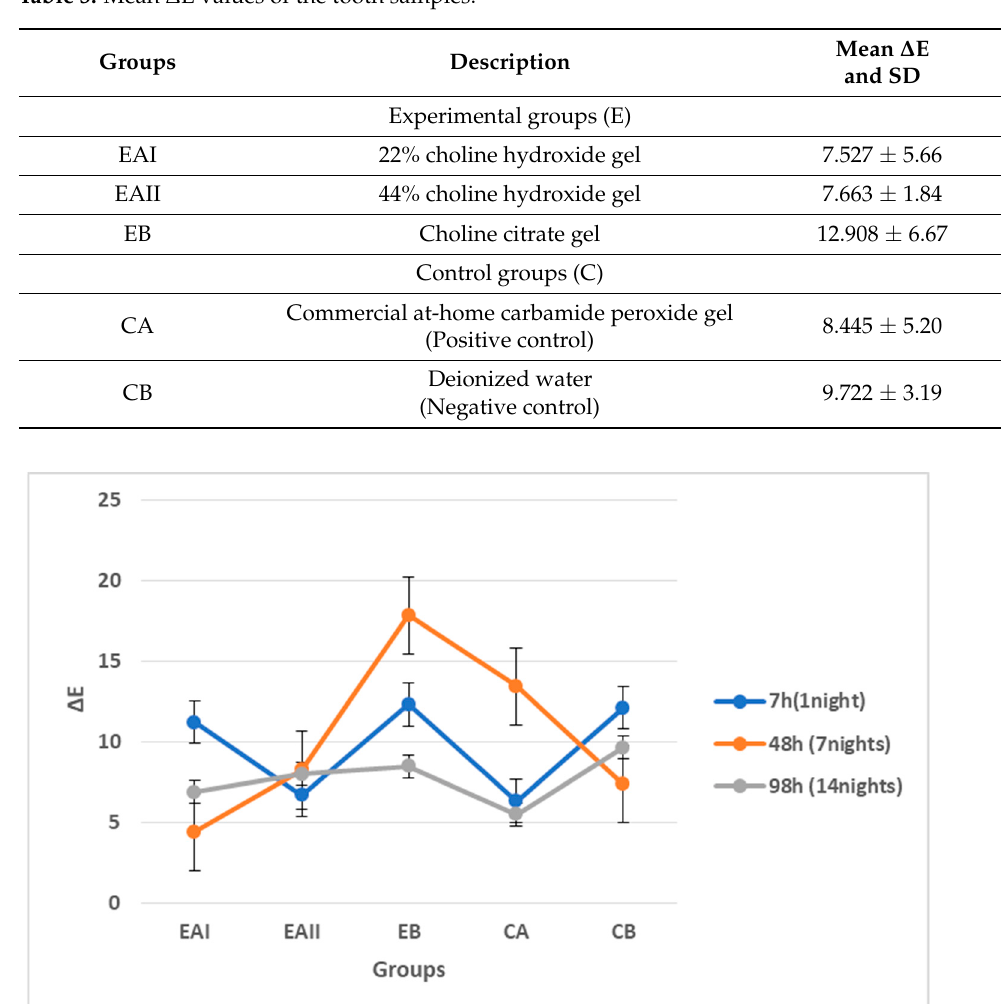
Table 3. Mean Δ E values of the tooth samples .